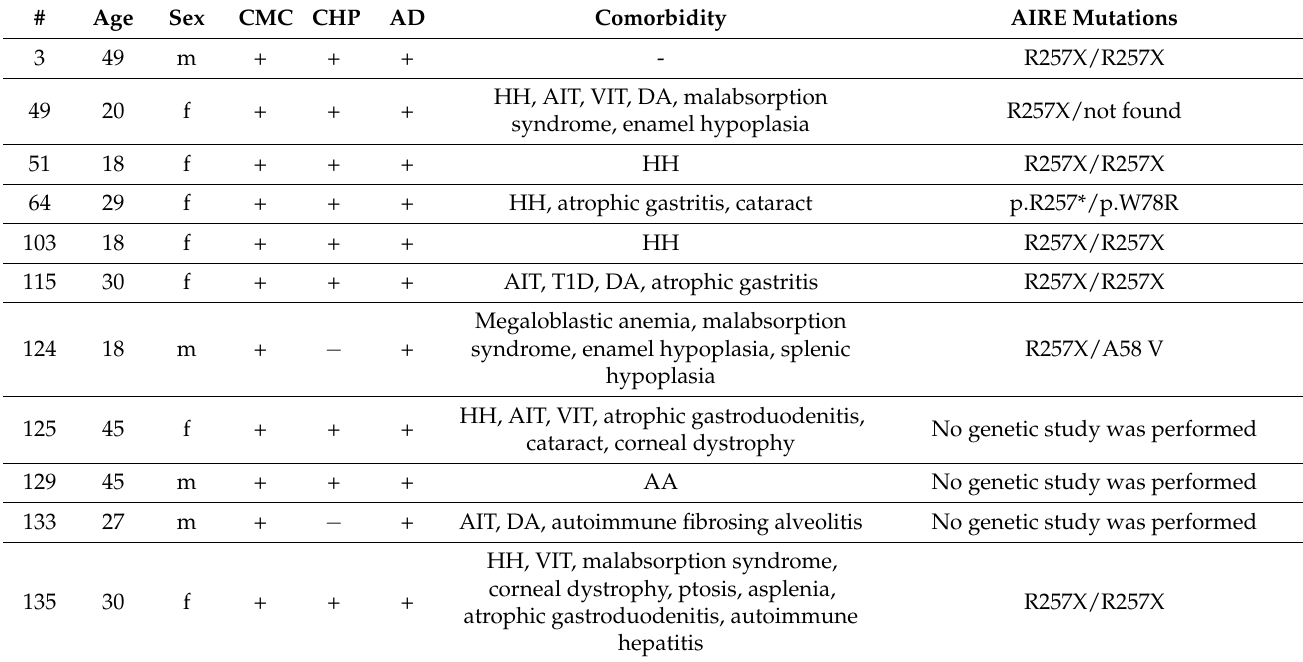
Table 1. APS-1 Patients.